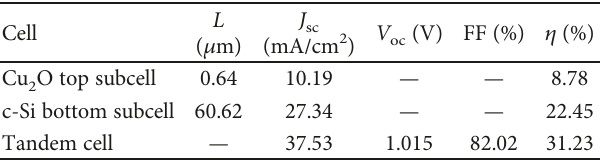
c-Si bottom subcell 60.62